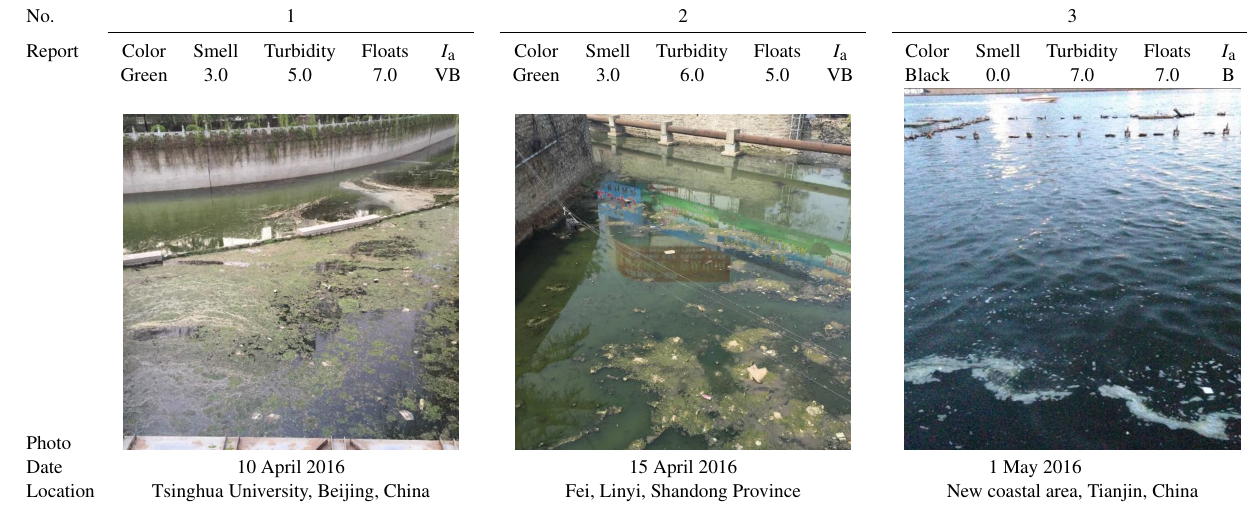
Table 3. Examples of reports for pollution disclosure.